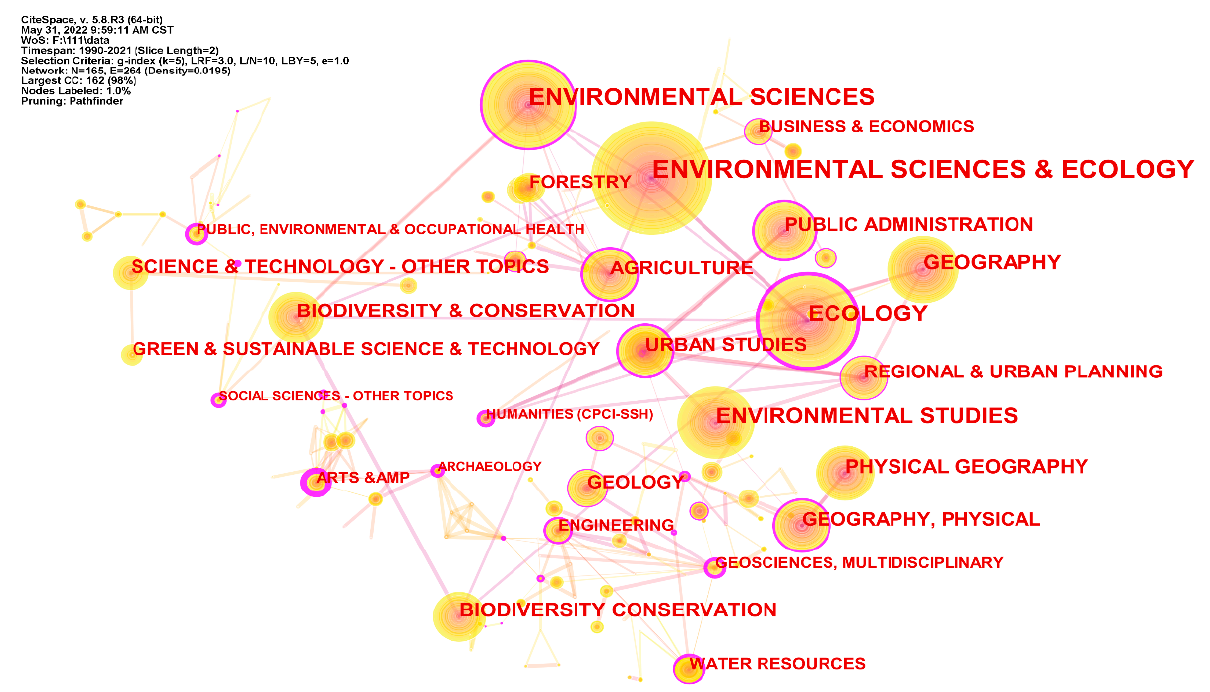
Figure 6. Distribution of the main research disciplines from 1990 to 2021.